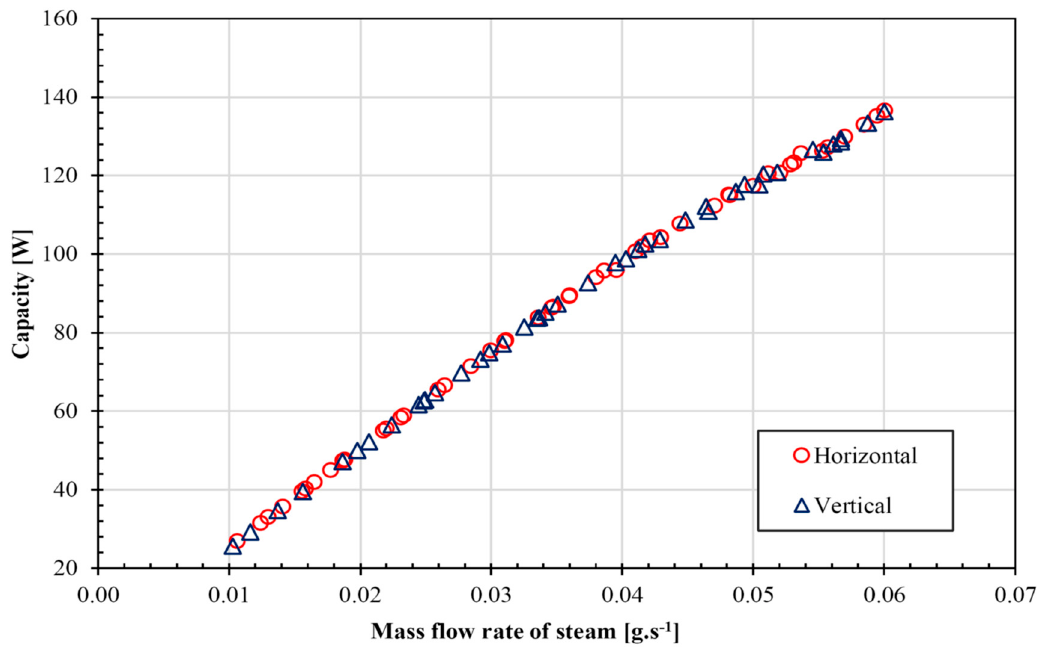
Figure 8. The e ff ect of the inlet of the steam mass flow rate on the condenser Figure 8. The effect of the inlet of the steam mass flow rate on the condenser capacity.